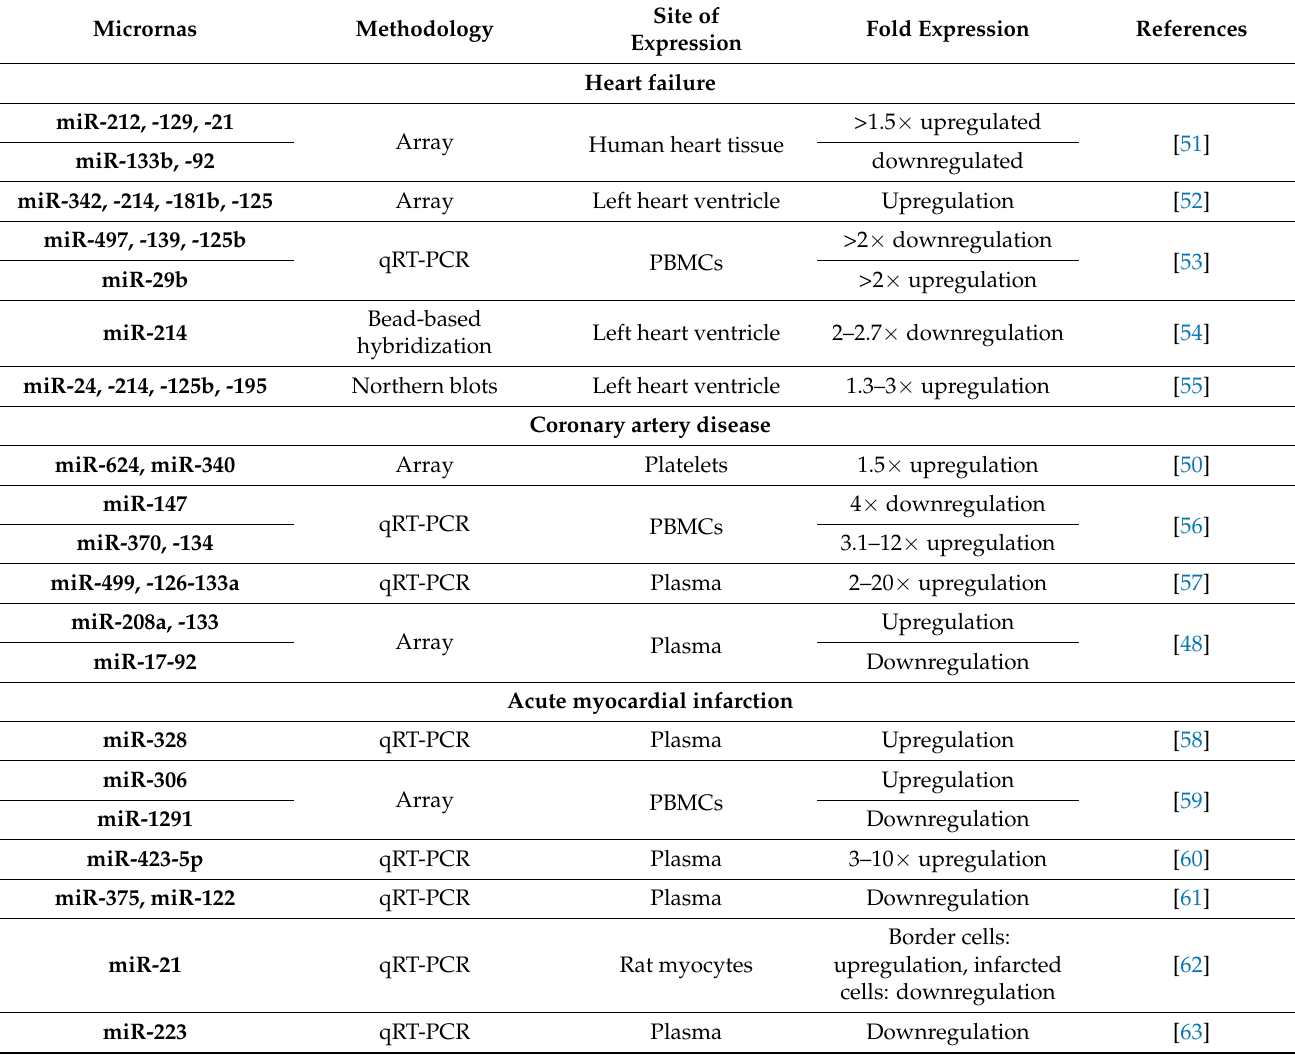
Table 2. Epigenetic modifications: role of microRNAs.